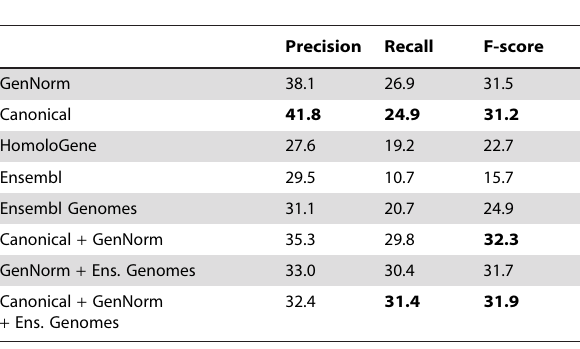
Table 4. Performance of the various normalization